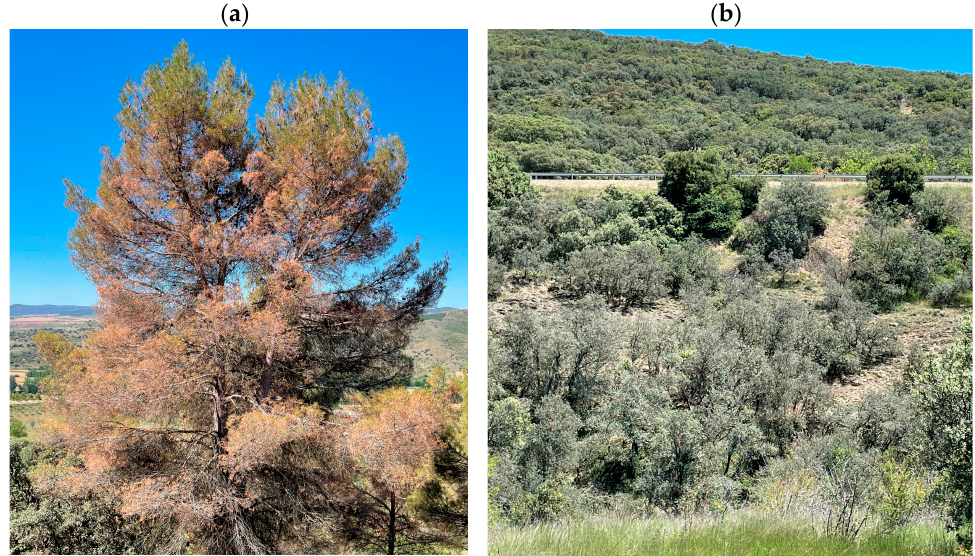
Figure 2. Images showing the damages on forests located in the study area caused by the severe drop in temperatures during January 2021: ( a ) leaf browning and shedding and shoot death in P. halepensis , and ( b ) leaf shedding and shoot death in Q. ilex .